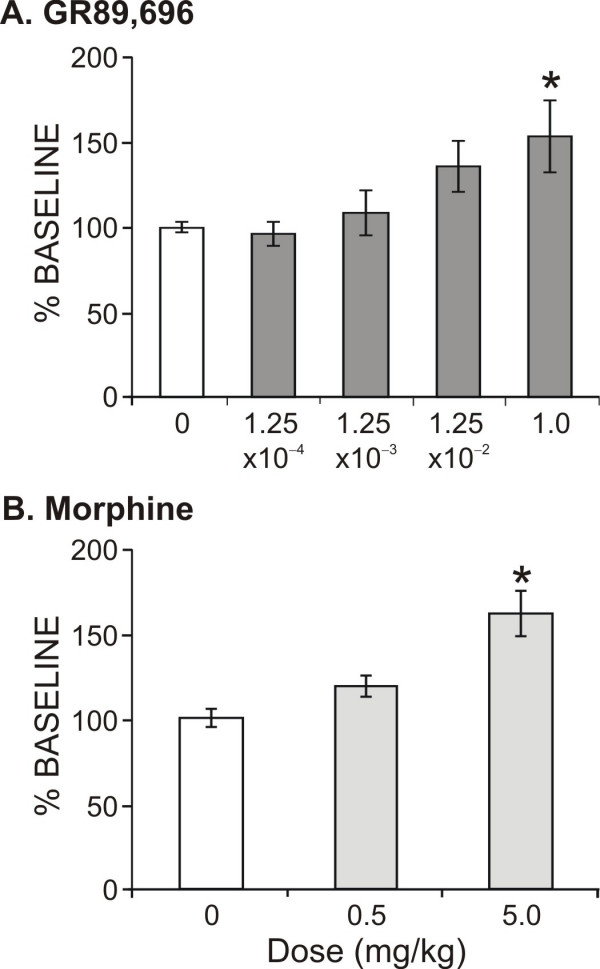
The effects of GR89,696 and morphine on normal thermal sensitivity were assessed and demonstrated that hindpaw withdrawal latency to thermal stimulation was significantly increased only at the highest doses tested for GR89,696 (N = 6) and morphine (N = 6).